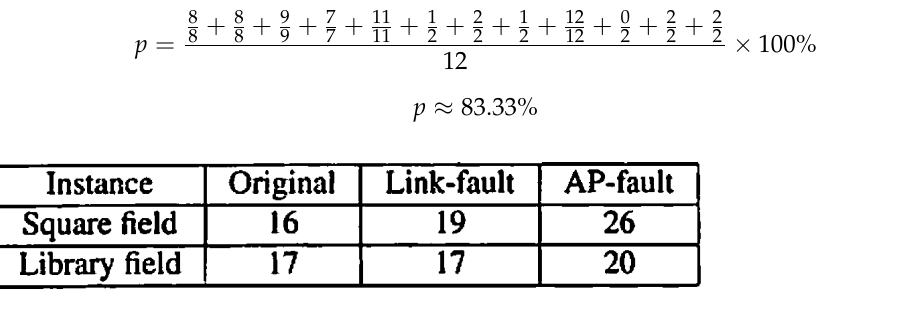
Figure 19. Printed table of scanned table image